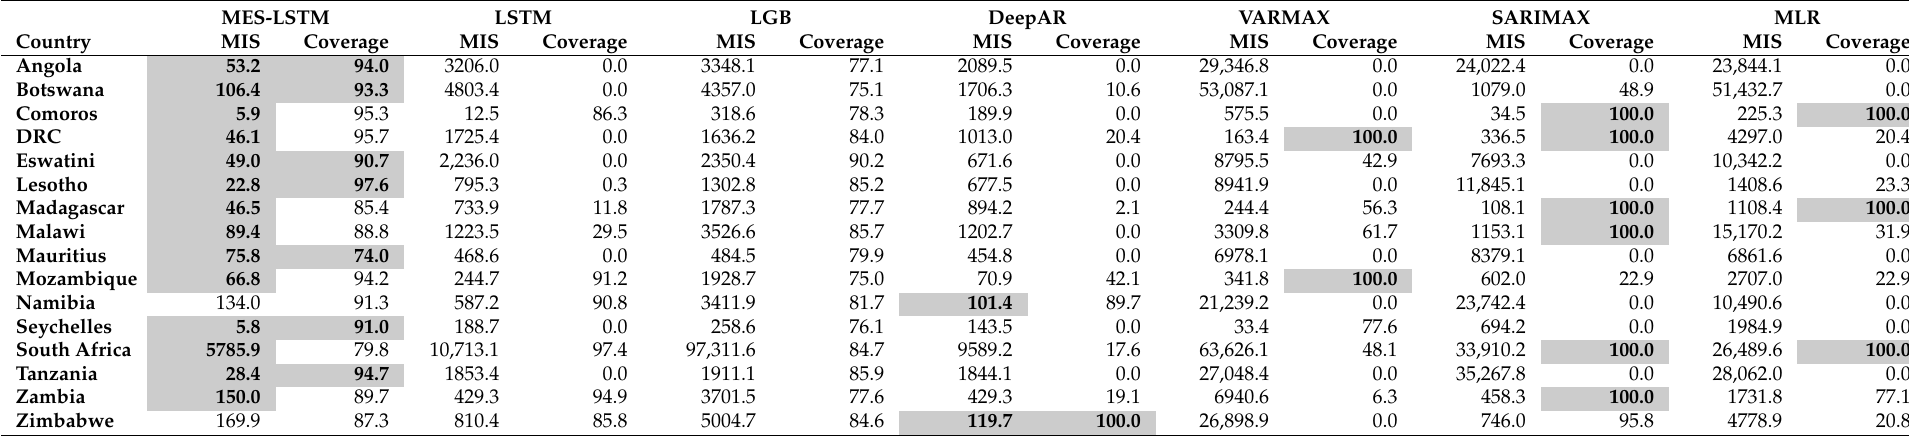
Table 7. Prediction Interval Accuracy Averaged Over All Trials for total deaths in SADC ( α =